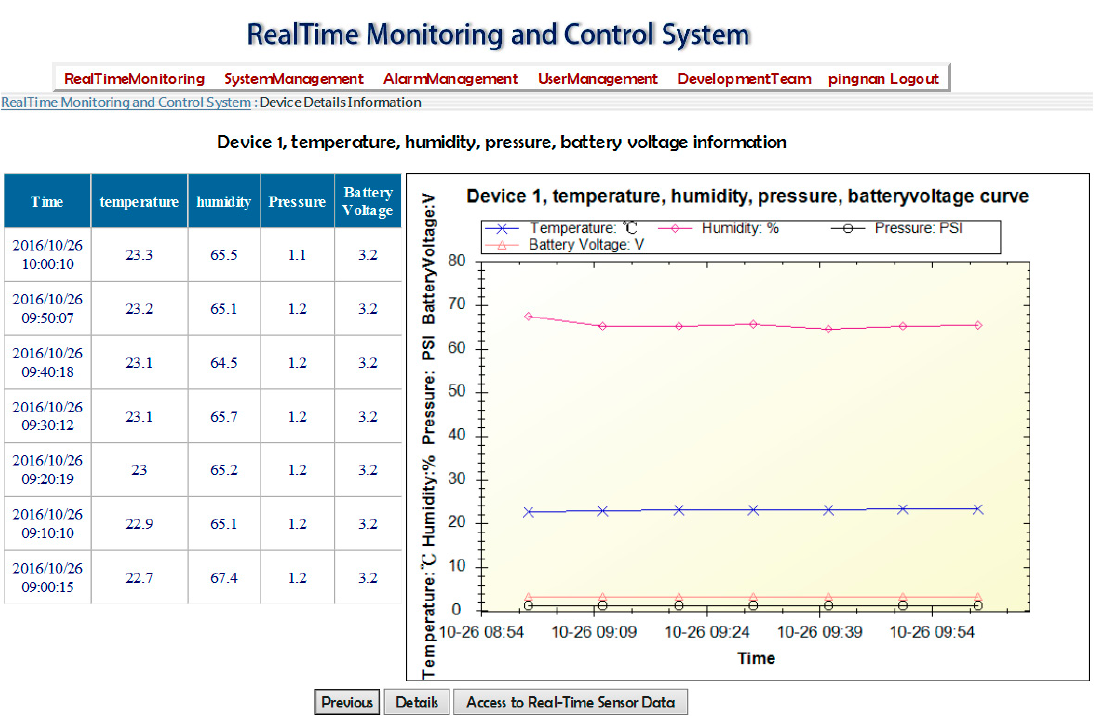
Figure 18. Real-time tracking of temperature, humidity, pressure, and battery power from Sensor 1 in Scenario 3.